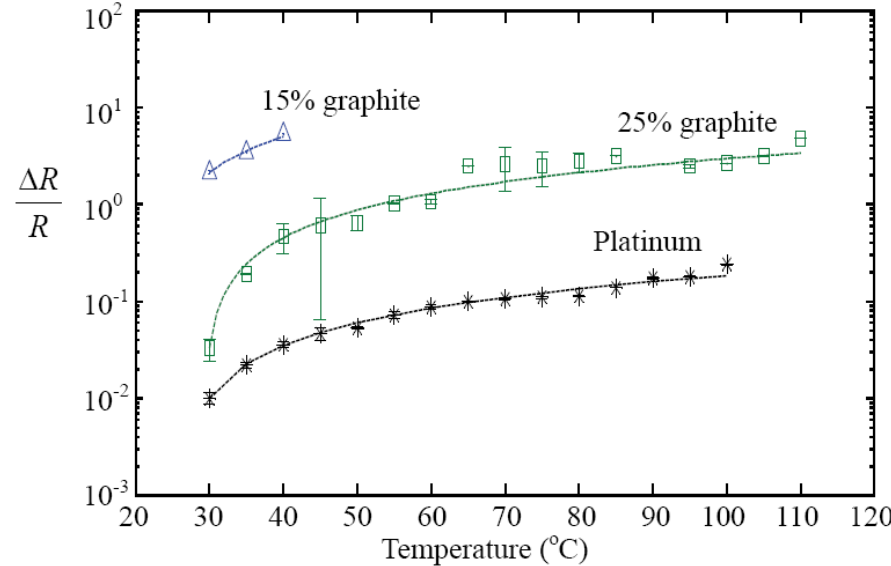
Figure 7. Measured resistance change of the graphite-PDMS composites subjected to different temperature values. The volume fractions of the graphite powder in the composites are 15% and 25%,